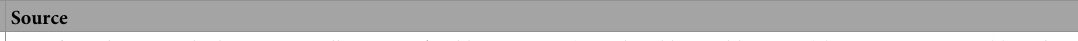
outside the study area). The sampling delay was defined as the period of time between EDP and the first date of blood sampling for biological testing. The reporting delay was defined as the period of time between EDP and the moment health authorities received report of the case. The exposure duration was defined as the time interval between EDP and the end of viremia of the imported case. Imported cases arriving in the study area 7 days or more after the date of symptom onset were excluded since they were considered to be no longer viremic. Vector control interventions data. Each observation was completed with data derived from details regarding entomological operations (entomological survey, vector control). Data were obtained from the French mosquito control agency, EID-Me´diterrane´e. The intervention delay was defined as the period of time between EDP and the first intervention focusing on vectors, whether an entomological survey or vector control. Entomological surveys aim to identify the presence of the vector–pre-imaginal stages or adults—while control measures are Table 3. Data